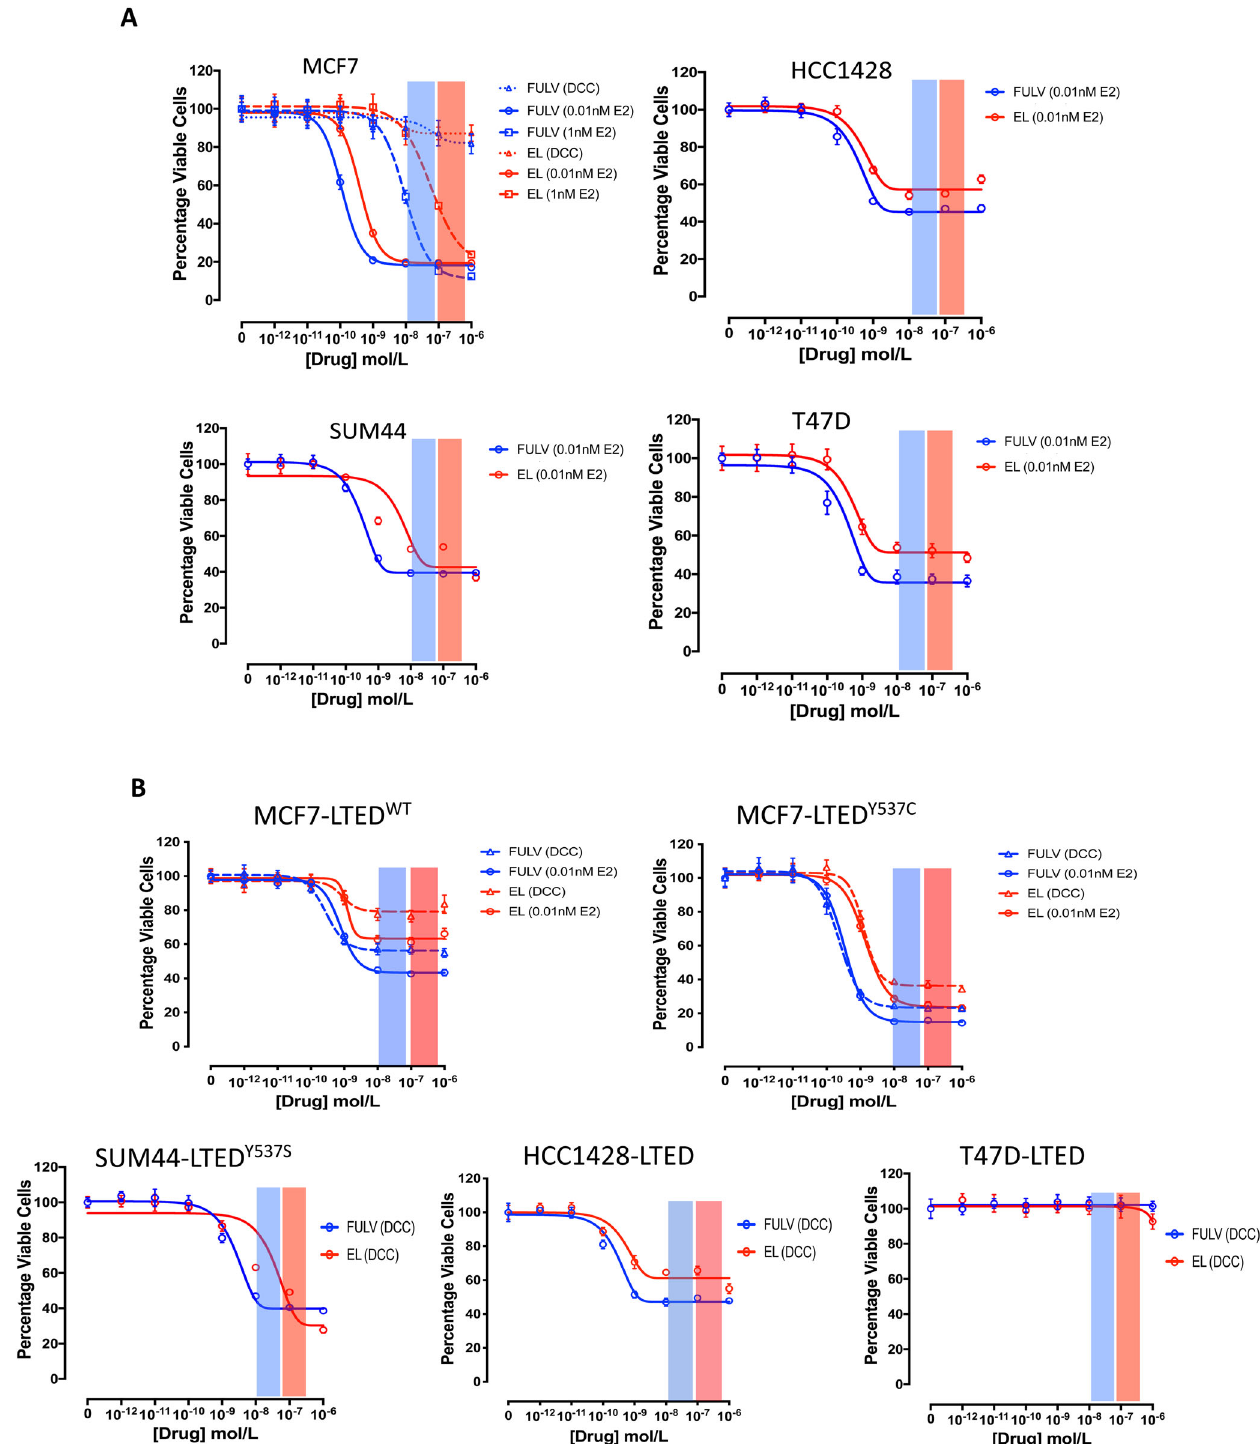
Fig. 1 Effect of elacestrant versus fulvestrant on cell proliferation. Effect of escalating concentrations of elacestrant (EL) or fulvestrant (FULV) in models of A endocrine sensitive and B resistant cell lines. MCF7 cells were treated in DCC medium in the absence of 17 β -estradiol (E2) (modelling E-deprivation on an AI) or in the presence of 0.01 and 1 nM E2. All other parental cell lines were tested in the presence of 0.01 nM E2. MCF7-LTED cell lines were tested in a DCC medium in the absence or presence of 0.01 nM E2. All other LTED models were tested in DCC alone. Cell viability was analysed using a CellTiter-Glo assay. Data were expressed as a percentage of viable cells in relation to vehicle control. Error bars represent means ± SEM. Red and blue shaded bars represent the clinically achievable doses for elacestrant and fulvestrant, respectively ( n = 3 biological experiments with six technical replicates per